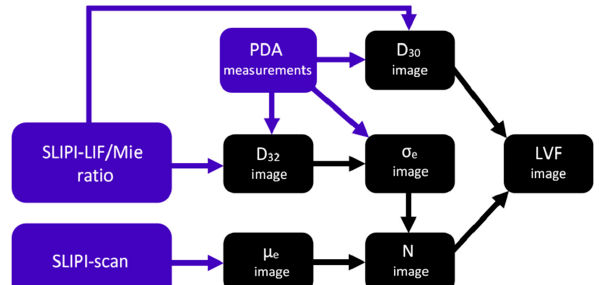
Figure 3. Simplified flowchart of the image post-processing for extracting several important spray scalar quantities such as the droplets Sauter mean diameter (SMD), the droplets number density (N), and the liquid volume fraction (LVF). The process is performed after recording spay images via a scanning procedure where the SLIPI-LIF signal, the SLIPI-Mie signal, and the light intensity transmitted through the spray are simultaneously